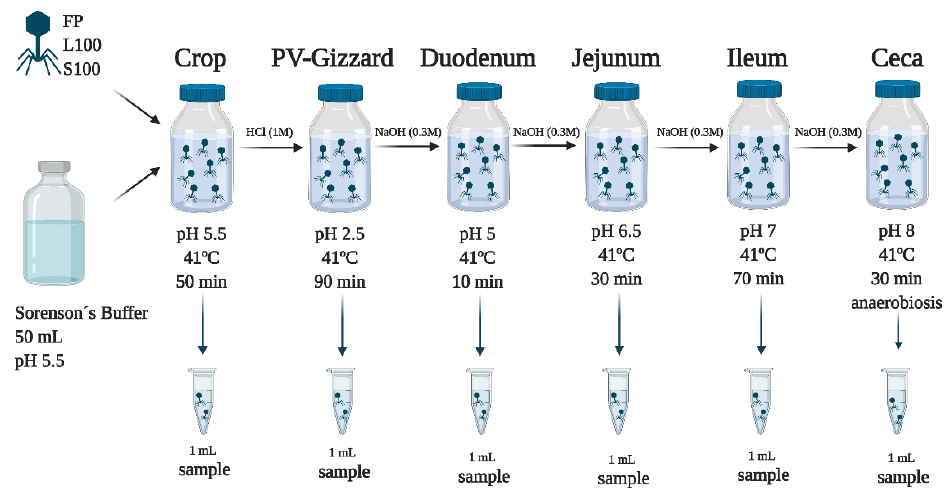
Figure 5. Scheme of the in vitro assay simulating the broiler to assess the release and survival of microencapsulated BP and the survival of non-encapsulated BP through the different pH, times and temperature conditions. The pH, transit-time and temperature of the crop (pH 5.5), proventriculus- gizzard (pH 2.5), duodenum (pH 5), ileum (pH 6.5), jejunum (pH 7), and ceca (pH 8 in anaerobiosis), were simulated. FP: free BP, L100: encapsulated BP with the polymer Eudragit ® L100; S100: encapsulated BP with the polymer Eudragit ® S100. Created with BioRender.com.